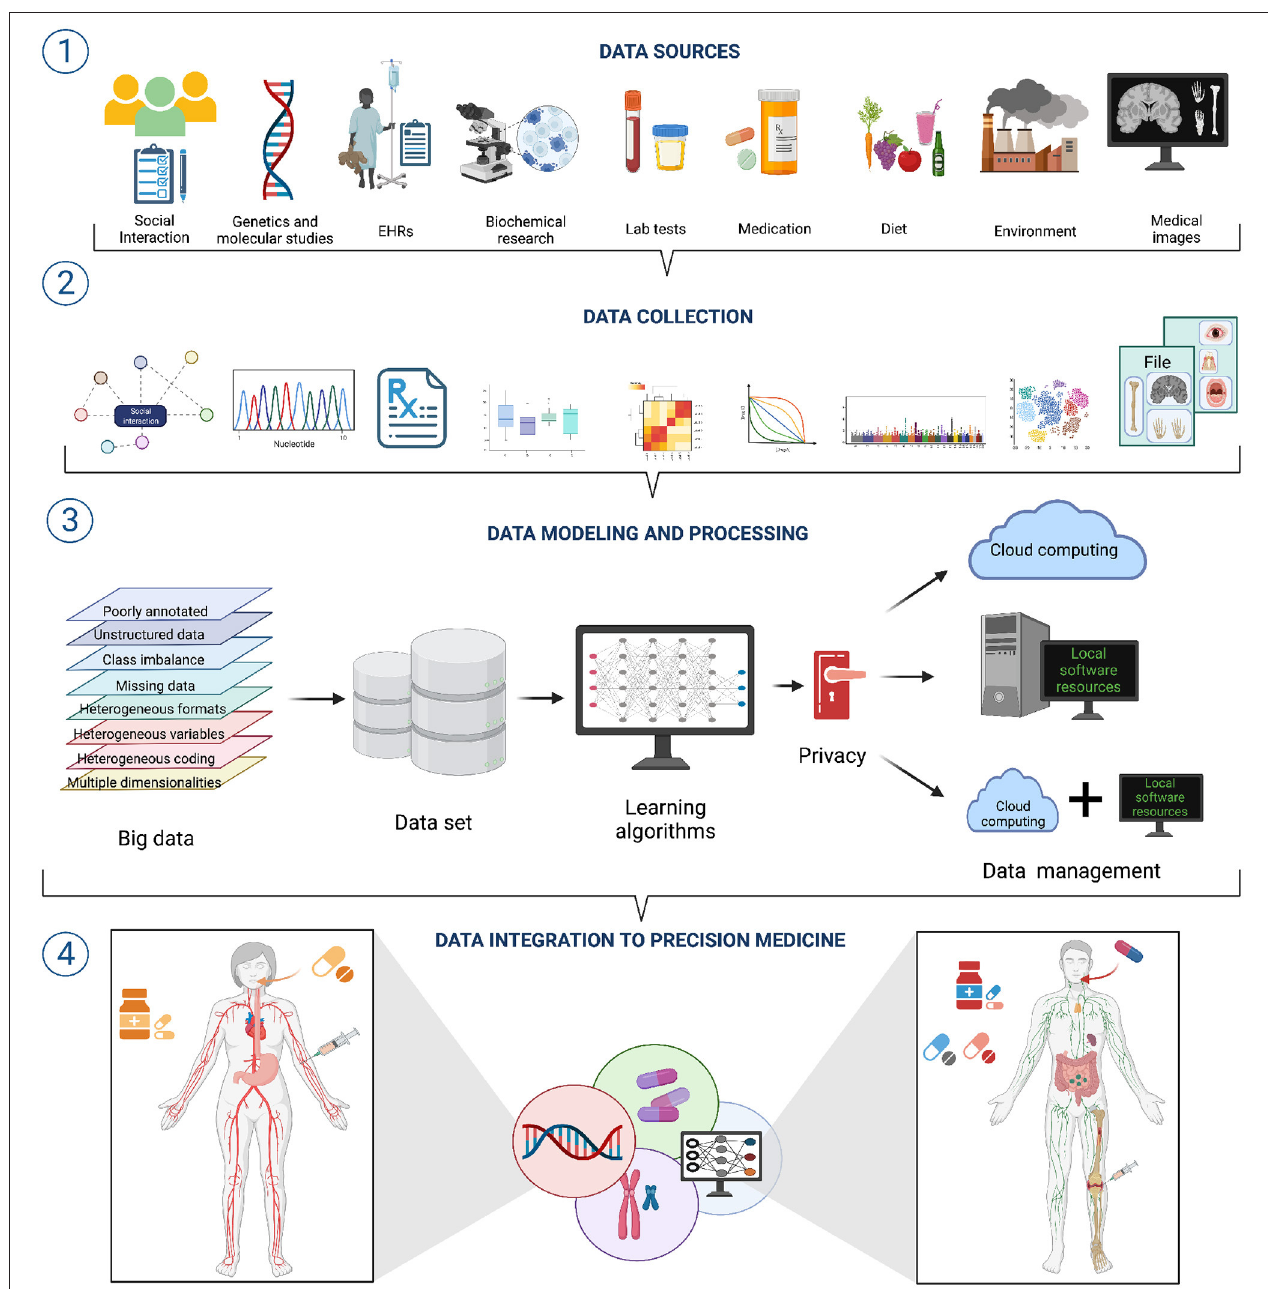
FIGURE 1 | A workflow for data integration for AI/ML modeling in precision medicine. 1 A wide variety of data sources with diverse features exists. Hence, different approaches to data collection and pre-processing are needed 2 . 3 Integrating such diverse and heterogeneous data is one of the grand challenges to the successful application of AI/ML approaches to Precision Medicine. Overcoming such challenges will bring important improvements to Precision Medicine 4